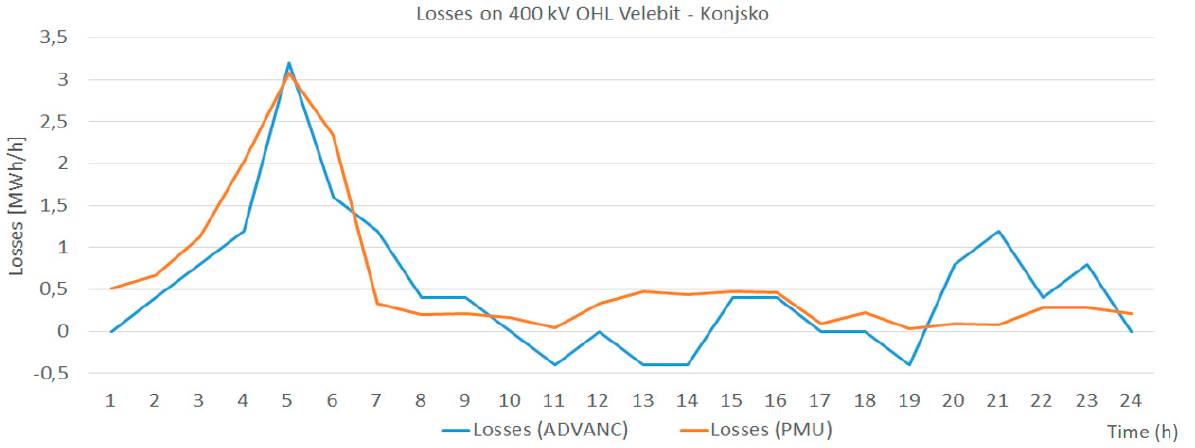
Figure 15. Comparison of total losses on the 400 kV OHL Velebit-Konjsko from ADVANC and PMU measurements.